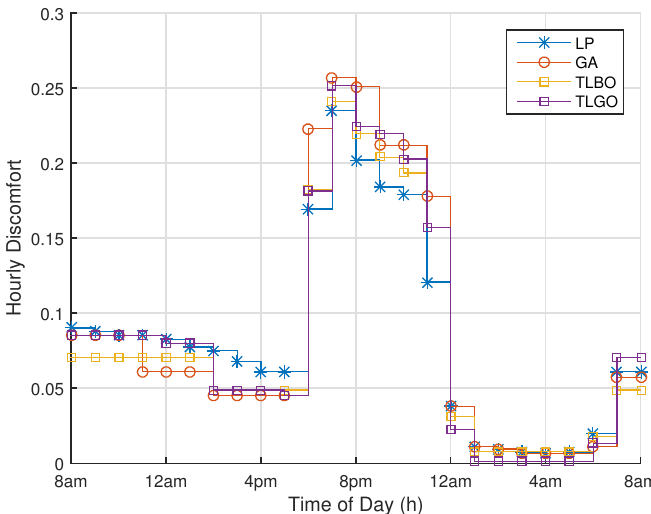
Figure 8. Hourly discomfort of appliances under DAP (1 h time slot).